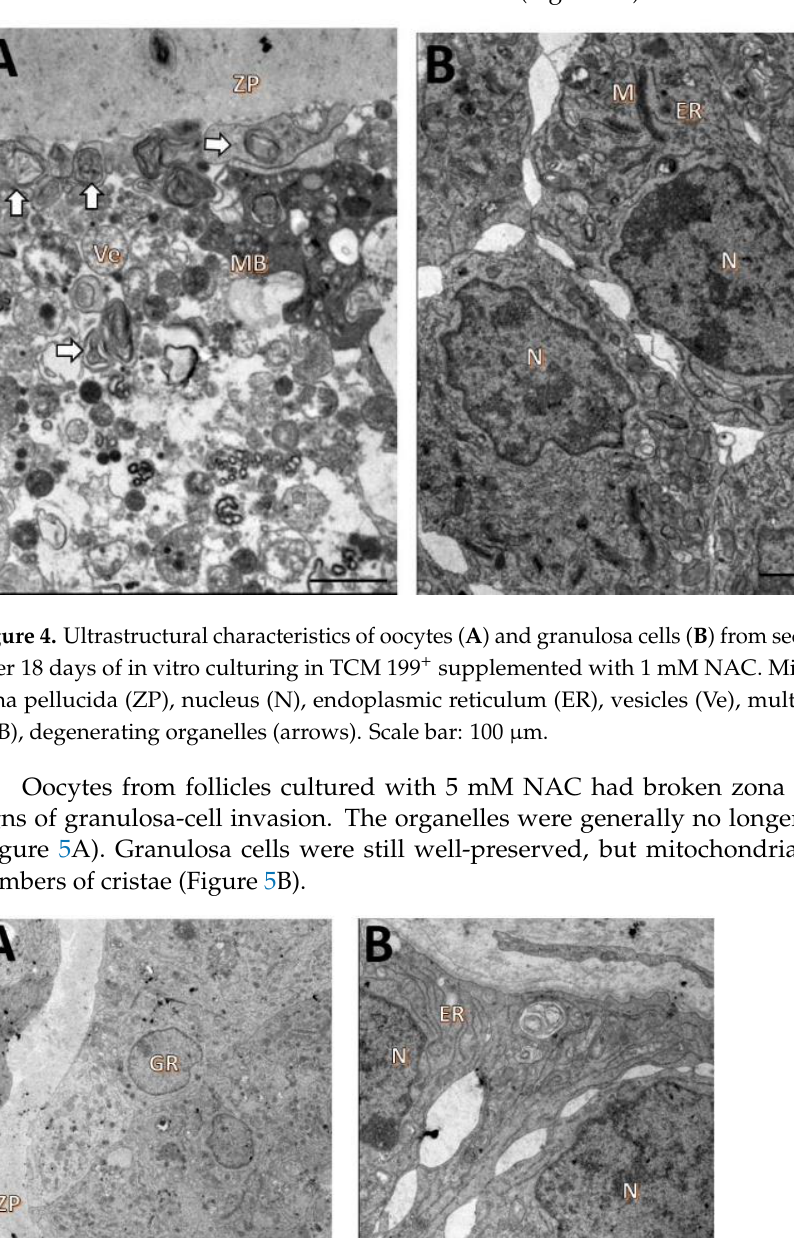
Figure 5. Ultrastructural characteristics of oocytes ( A ) and granulosa cells ( B ) from secondary folli- cles after 18 days of in vitro culturing in TCM 199 + supplemented with 5 mM NAC. Ooplasm (Oo), mitochondria (M), zona pellucida (ZP), nucleus (N), endoplasmic reticulum (ER), granulosa cells (GR). Scale bar: 100 µm.